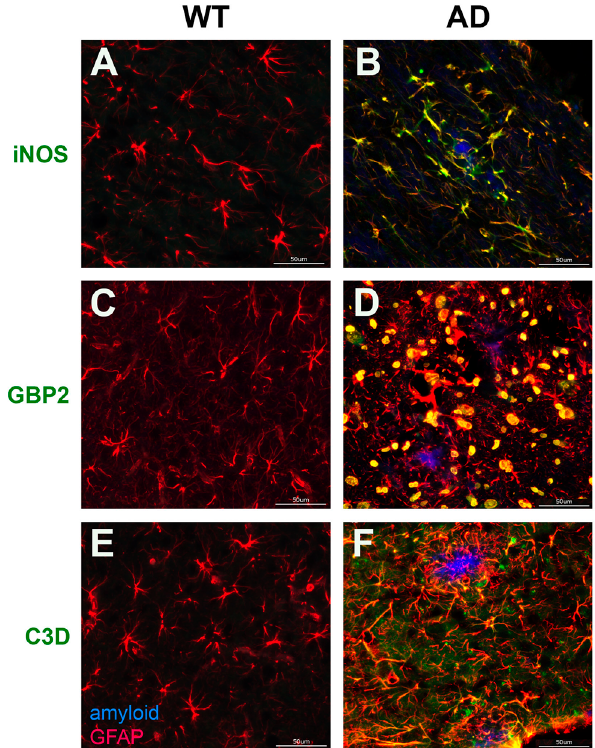
Figure 6. Validation of A β 42 fibril induced astrocyte genes by immunolabeling. Increased immunolabeling for iNOS, GBP2, and C3D co-localized with astrocytes surrounding amyloid plaques. Brain sections from 15 M WT rats ( A , C , E ) and F344Tg-AD rats ( B , D , F ) were labeled with mAb66.1 to detect amyloid plaques (blue) and goat polyclonal antibody to GFAP for astrocytes (red), as well as rabbit polyclonal antibodies to iNOS, GBP2, and C3D (green). Scale bars = 50 µm.